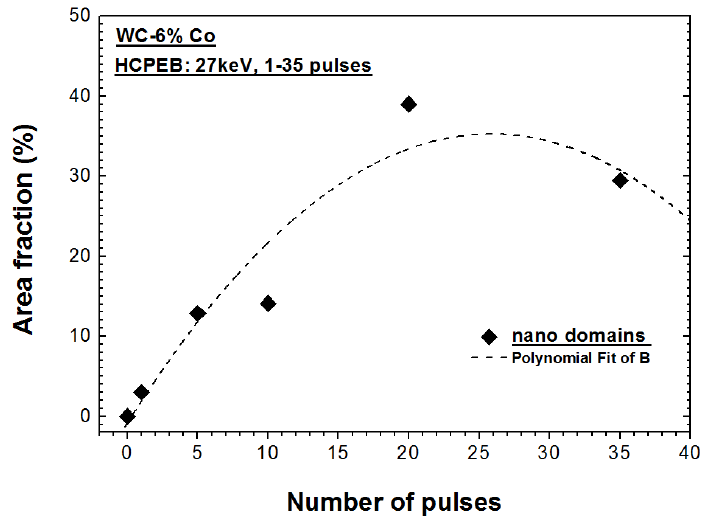
Figure 6. Area fraction evolution of nano domains on the surface of WC-6% Co hard alloy as-treated by HCPEB with increasing pulse numbers.